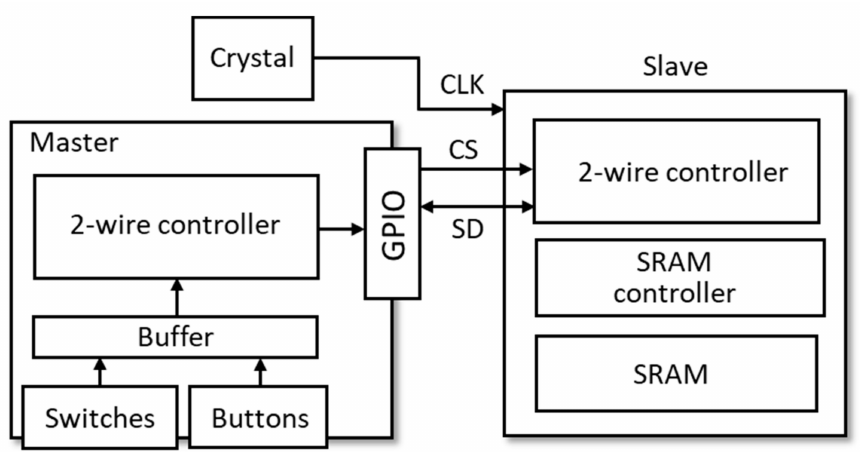
Figure 9. The system diagram of an oscillator control application.